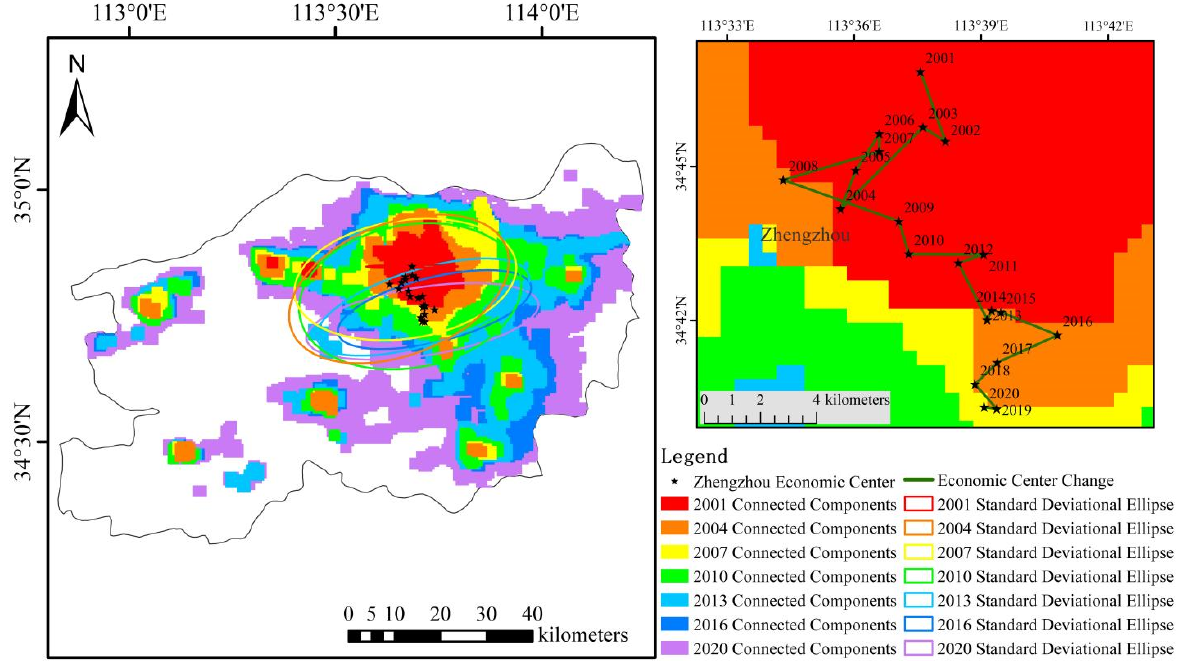
Figure 16. Zhengzhou weighted standard deviation ellipses, economic centers, and trends in eco- nomic center changes for GDP spatialization data. Table 4. Zhengzhou information from 2001–2020 on the parameters of the economic